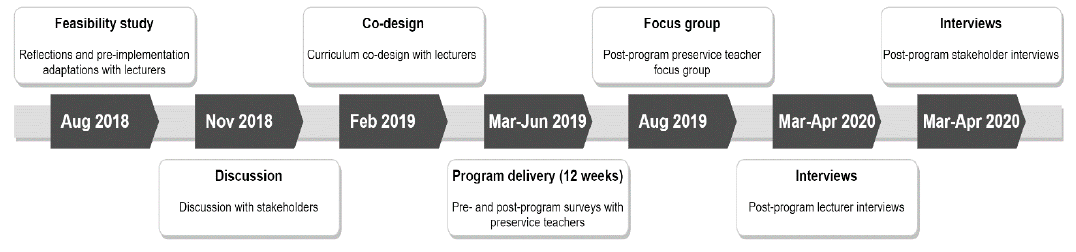
Figure 2. Project timeline.